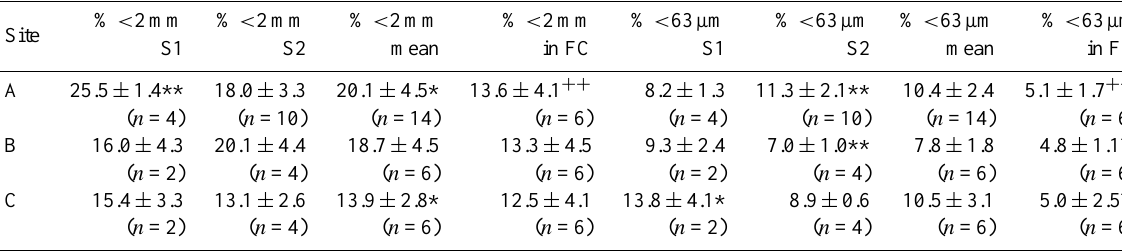
Table 5. Mean values ± standard deviation of the fraction of fine sediment ( < 2mm) in the accumulation baskets and the fraction of sediment < 63µm of the accumulated fine sediment during the two spawning seasons S1 (2009/2010) and S2 (2010/2911) and in freeze cores (FC) taken in winter 2008/2009 at the three sites.